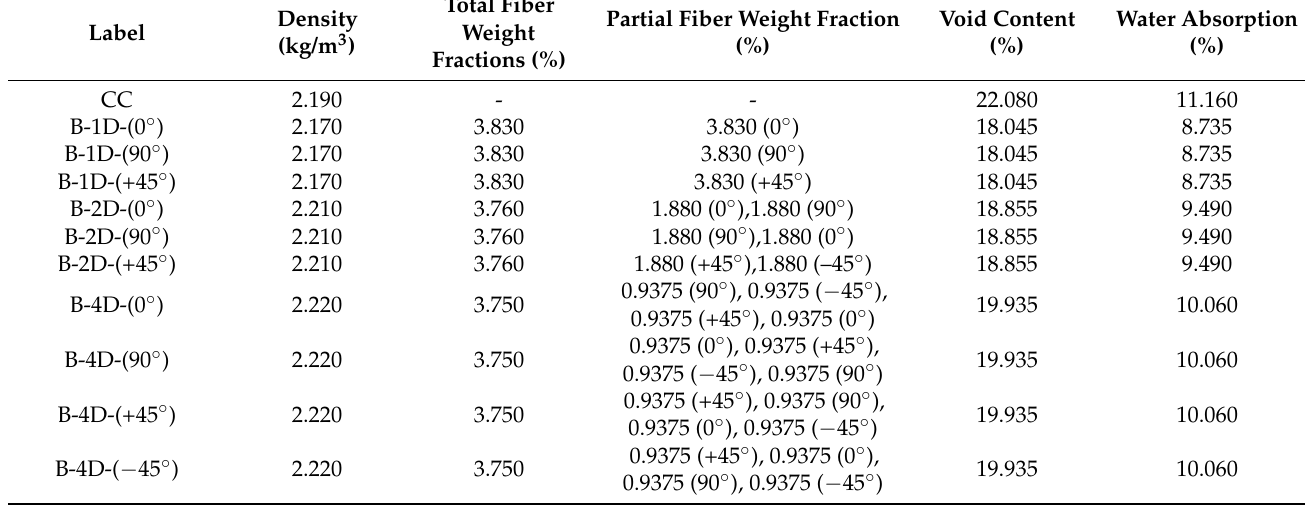
Table 3. Specifications of off-axis and principle flexural specimen of the multiaxis 3D basalt fiber